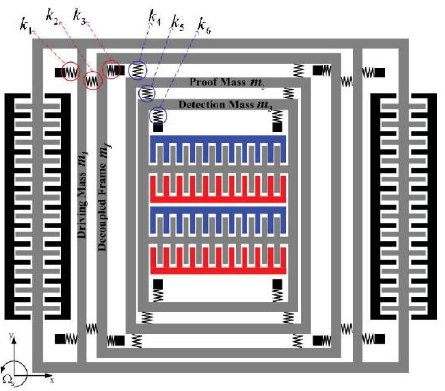
Figure 1. Structural schematic diagram of the micro gyroscope with two-degree-of-freedom (2-DOF) drive-mode and sense-mode.